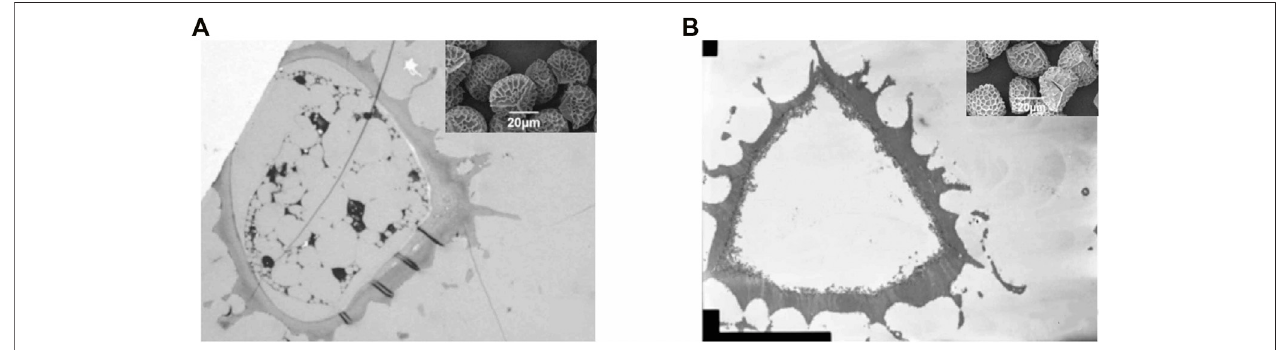
FIGURE 3 | (A) , an SEM of clubmoss ( Lycopodium clavatum ) before removal of the biologically active core, and (B) , the exine shell of the